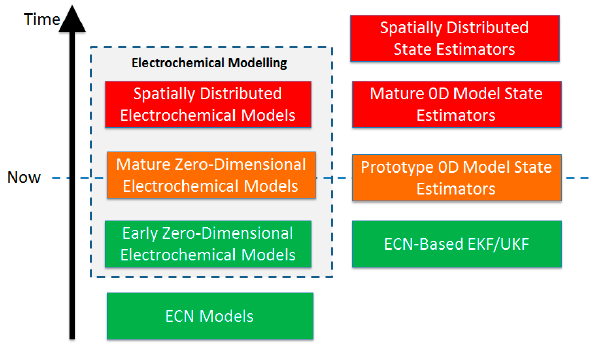
Figure 5. Expected road map for state estimation in Li-S: colors are a ‘traffic light’ indication of technology readiness, with green representing most ready, and red representing furthest off [58].